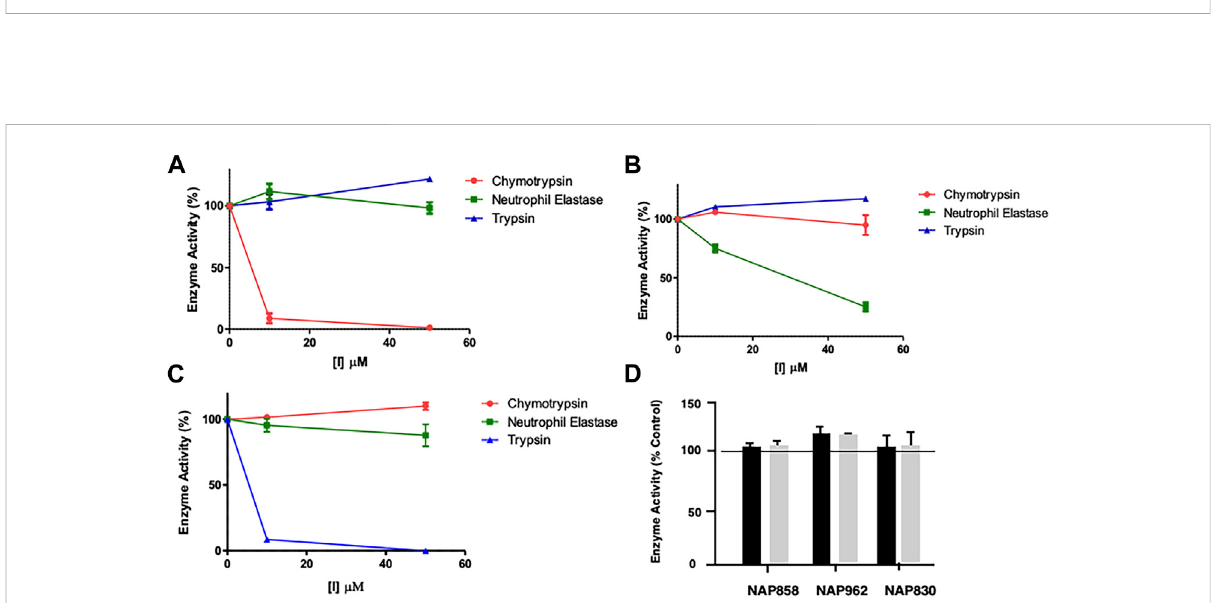
FIGURE 5 Results of “ off-target “ studies. NAP849 (A) , NAP800 (B) and NAP830 (C) were tested against trypsin, chymotrypsin, and NE. Samples (approx. 0.01 μ g) of each protease were incubated with the indicated concentrations of test compound for 2 min, in PBS, pH 7.4, at 37 ° C. (D) NAP858, NAP962andNAP849weretestedagainstcathepsinBattheindicatedconcentrationsin0.1 MMES,pH6.1,containing1 mMEDTA,for2 min,at37 ° C. Aliquots (approx. 10 μ L) of each incubation sample were then added to a fresh sample (990 μ L) of PBS for the serine proteases and MES for cathepsin B, containing the appropriate substrate for each protease, to measure their residual activity. Controls incubations were performed in the absence of test compound, but in the presence of an appropriate volume of DMF vehicle used to prepare stock solutions of each inhibitor under